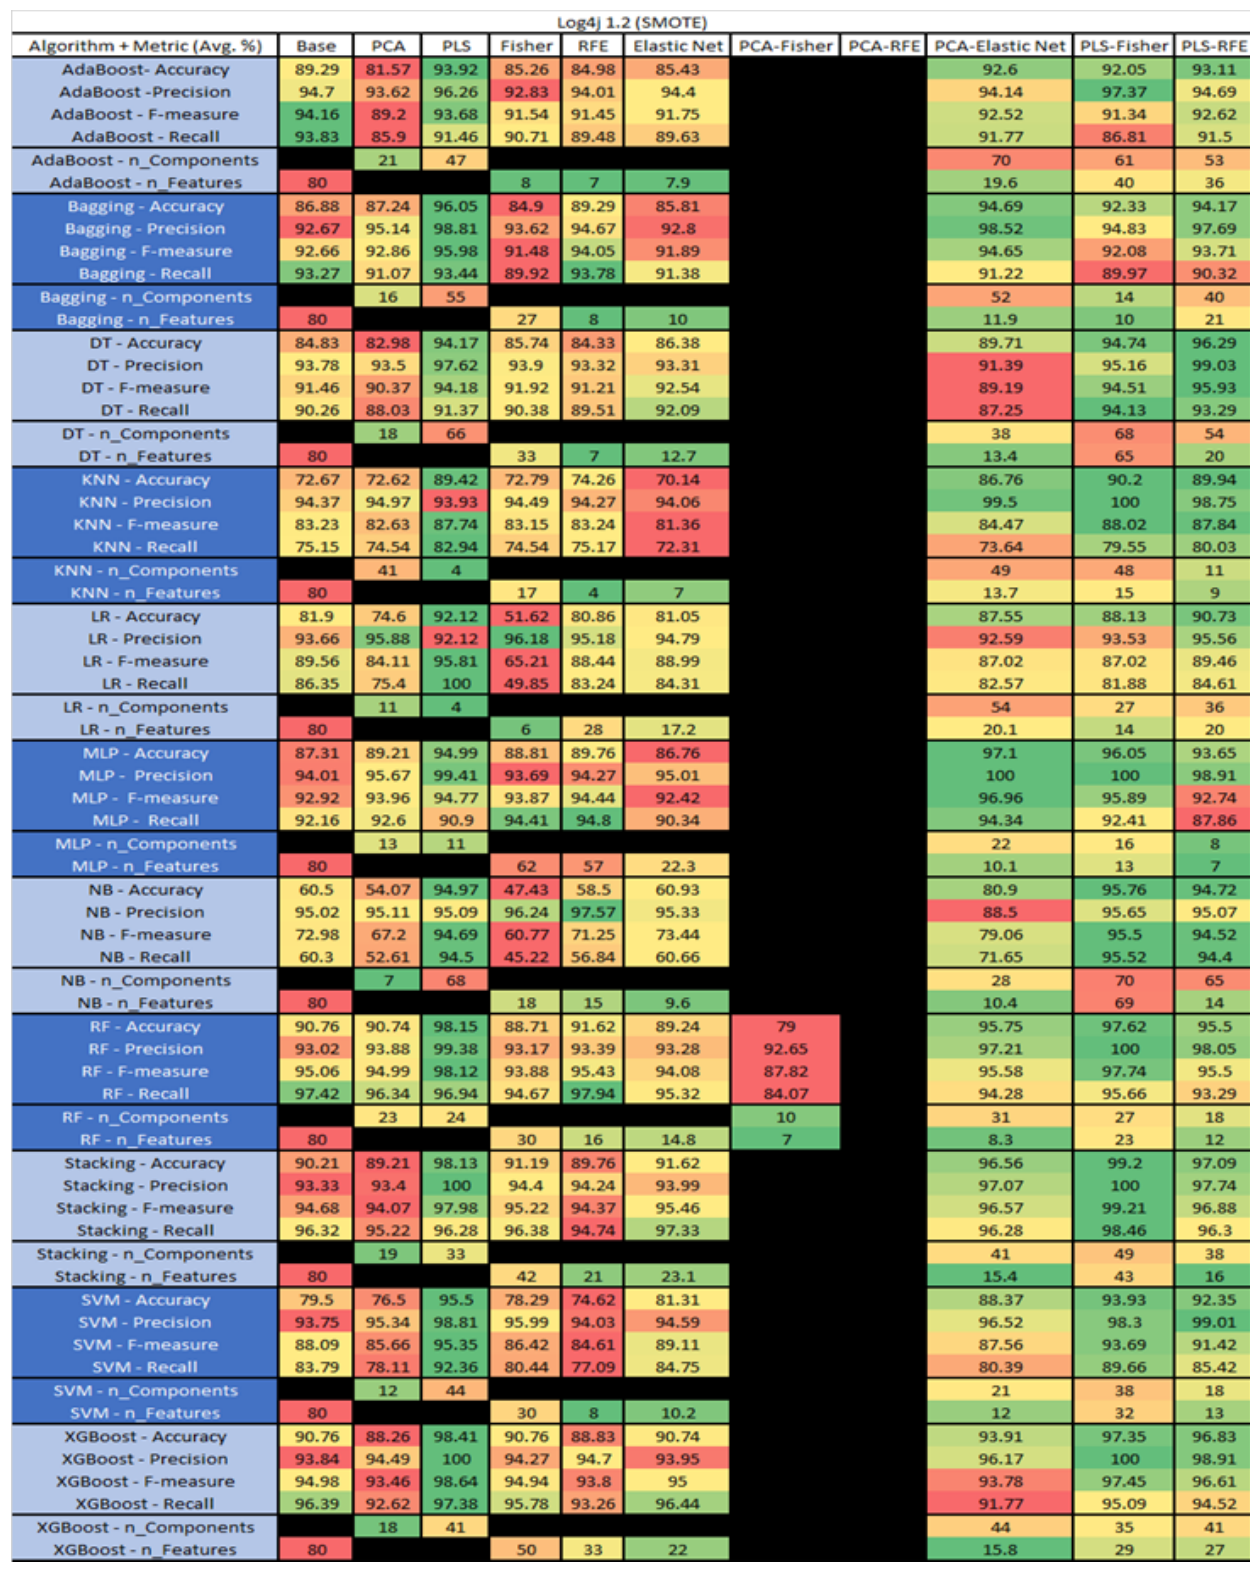
Figure 31. Log4j 1.2 SMOTE PROMISE Results Data